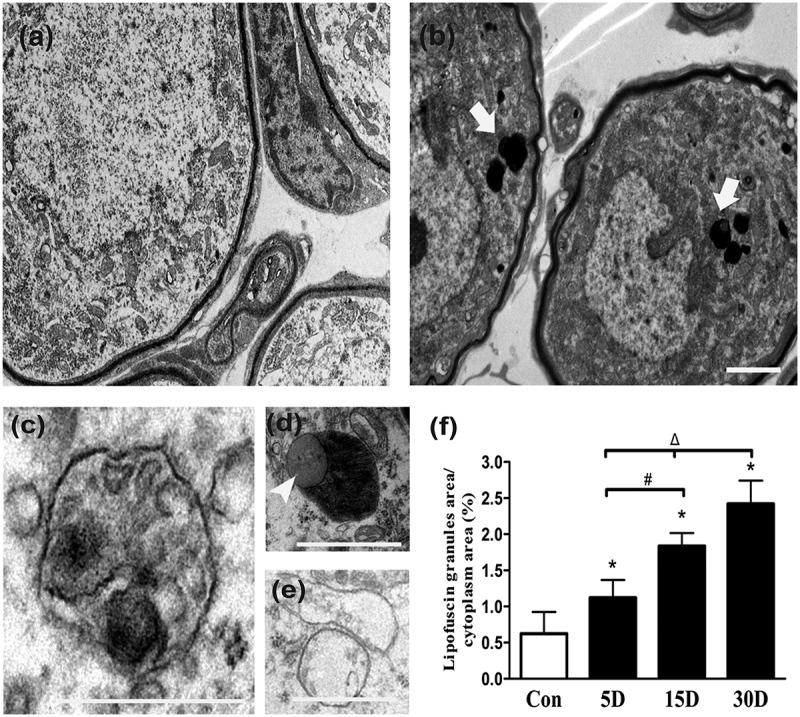
Ultrastructural observation of lipofuscins in the cochlear spiral ganglion neurons of mice. (a) Ultrastructure features of the SGNs in normal mice (8 w). (b) Thirty days after administration, lipofuscins (white arrows) of degenerated SGNs aggregated progressively. (c) Autophagic vacuole. (d) Intracellular inclusion body (white arrowhead) containing lipid droplets. (e) Enlarged and cristae-disrupted mitochondria. (f) The lipofuscin area in the degenerated SGN cytoplasm gradually increased with the progression of neurodegeneration. *, compared with that in the blank control group, the lipofuscin area within the degenerated SGN cytoplasm was significantly increased (P < 0.05); #, compared with that on the 5th day after ototoxic drug administration, the lipofuscin area within the degenerated SGN cytoplasm on the 15th day was significantly higher (P < 0.05); Δ, compared with the area at the previous observation point, the area of lipofuscin within the degenerated SGN cytoplasm was further increased by the 30th day after ototoxic drug administration (P < 0.05). Con, normal mice without drug treatment; 30D, 30 days after drug administration. Images of TEM were taken from the middle turn of cochlea. Scale bar: 1 µm.